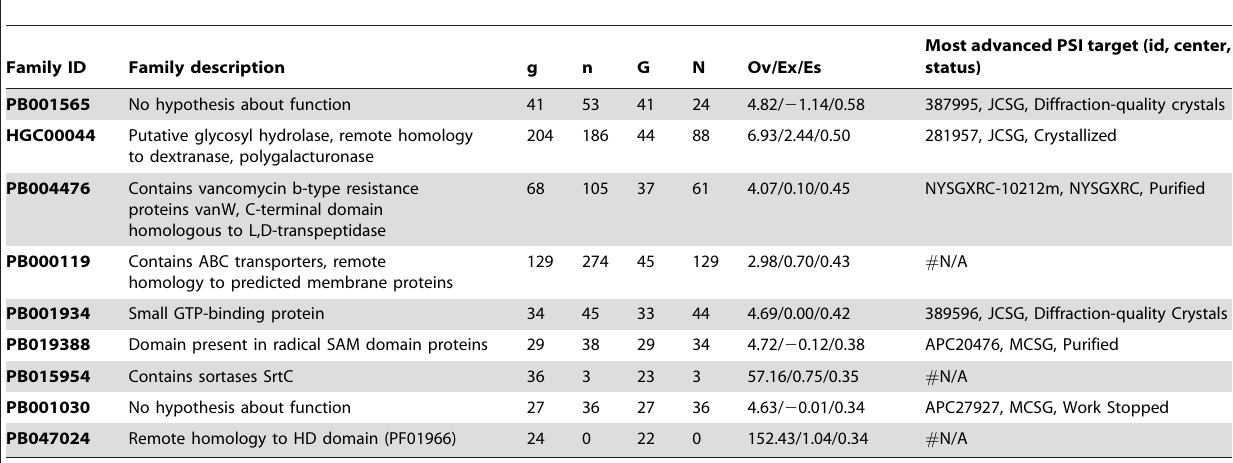
Table 6. 10 top most essential (Es) new families, from the set of over 180 curated novel families identified in this work.